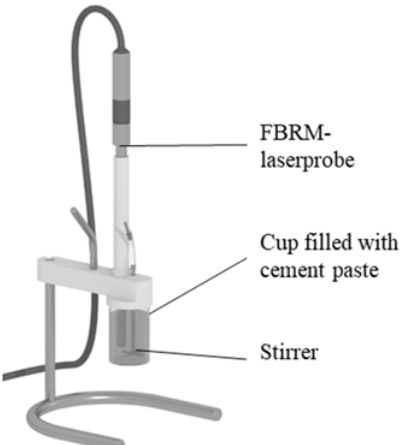
Figure 2. Experimental setup of the FBRM ‐ measurements.